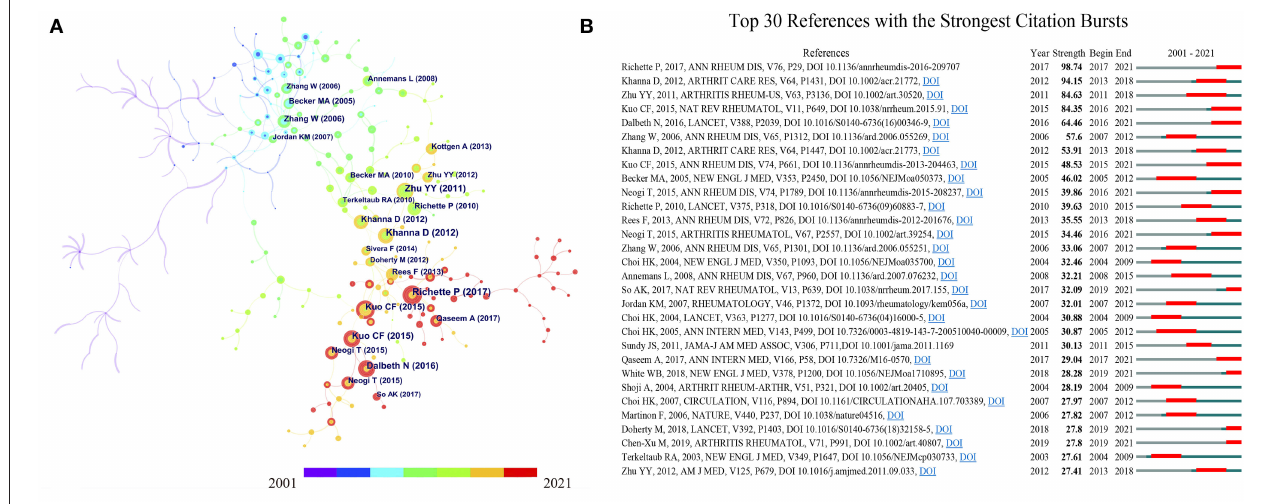
FIGURE 4 | (A) The co-cited reference knowledge map. (B) The top 30 references with the strongest citation